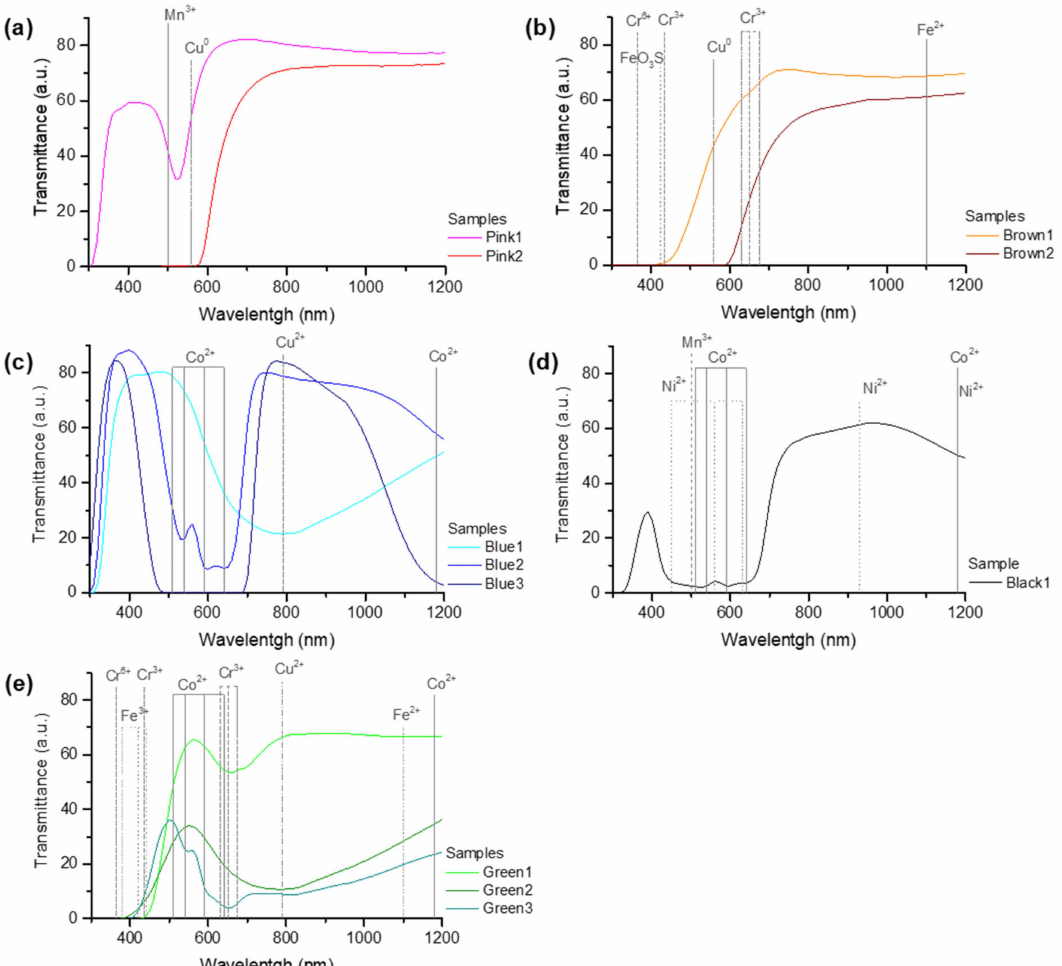
Figure 4. Transmittance spectra of the different colored flashed glasses: ( a ) pink, ( b ) brown, ( c ) blue, ( d ) black, and ( e )